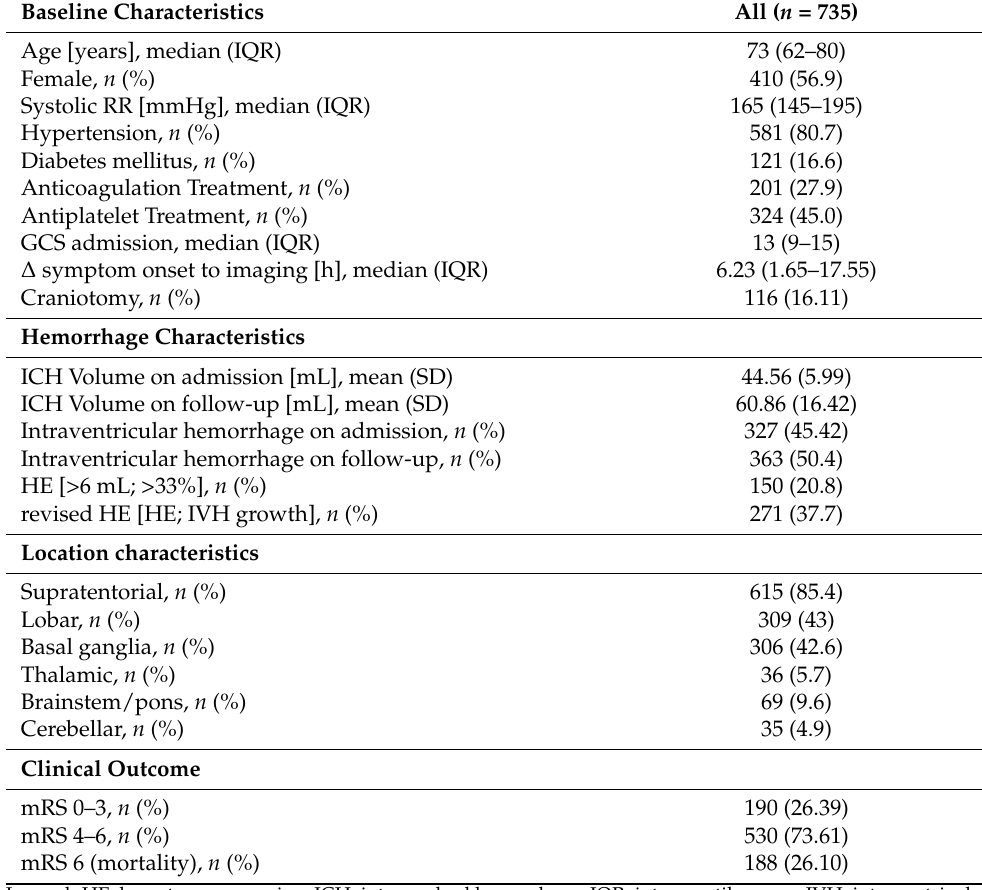
Table 1. Baseline demographics, as well as clinical and radiological characteristics in patients with and without intraventricular hemorrhage growth (IVH growth), in patients with intracerebral hemorrhage.